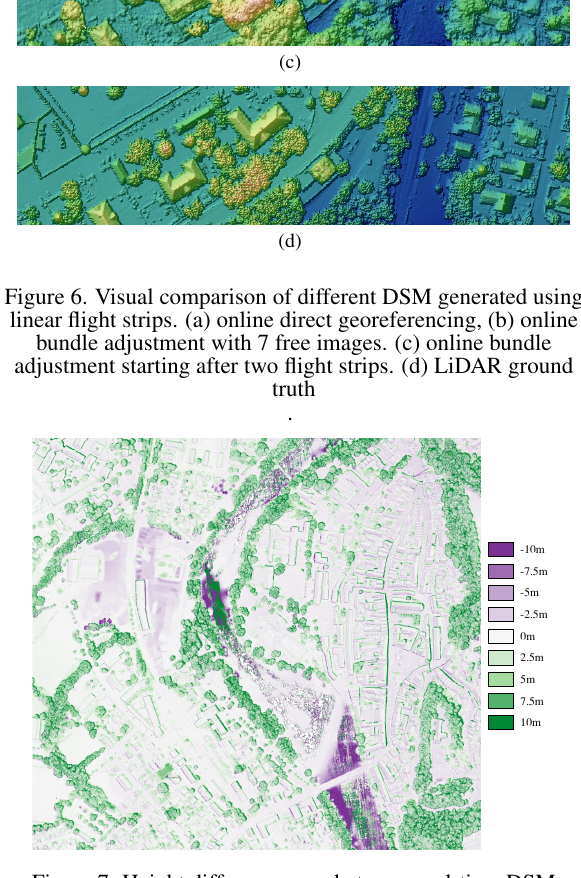
Figure 7. Height difference map between real-time DSM generated using the the 2 strip adjustment method and LiDAR point cloud. Systematic differences due to vegetation change are visible. Larger height differences around buildings indicate local rotations or shifts of the merged real-time